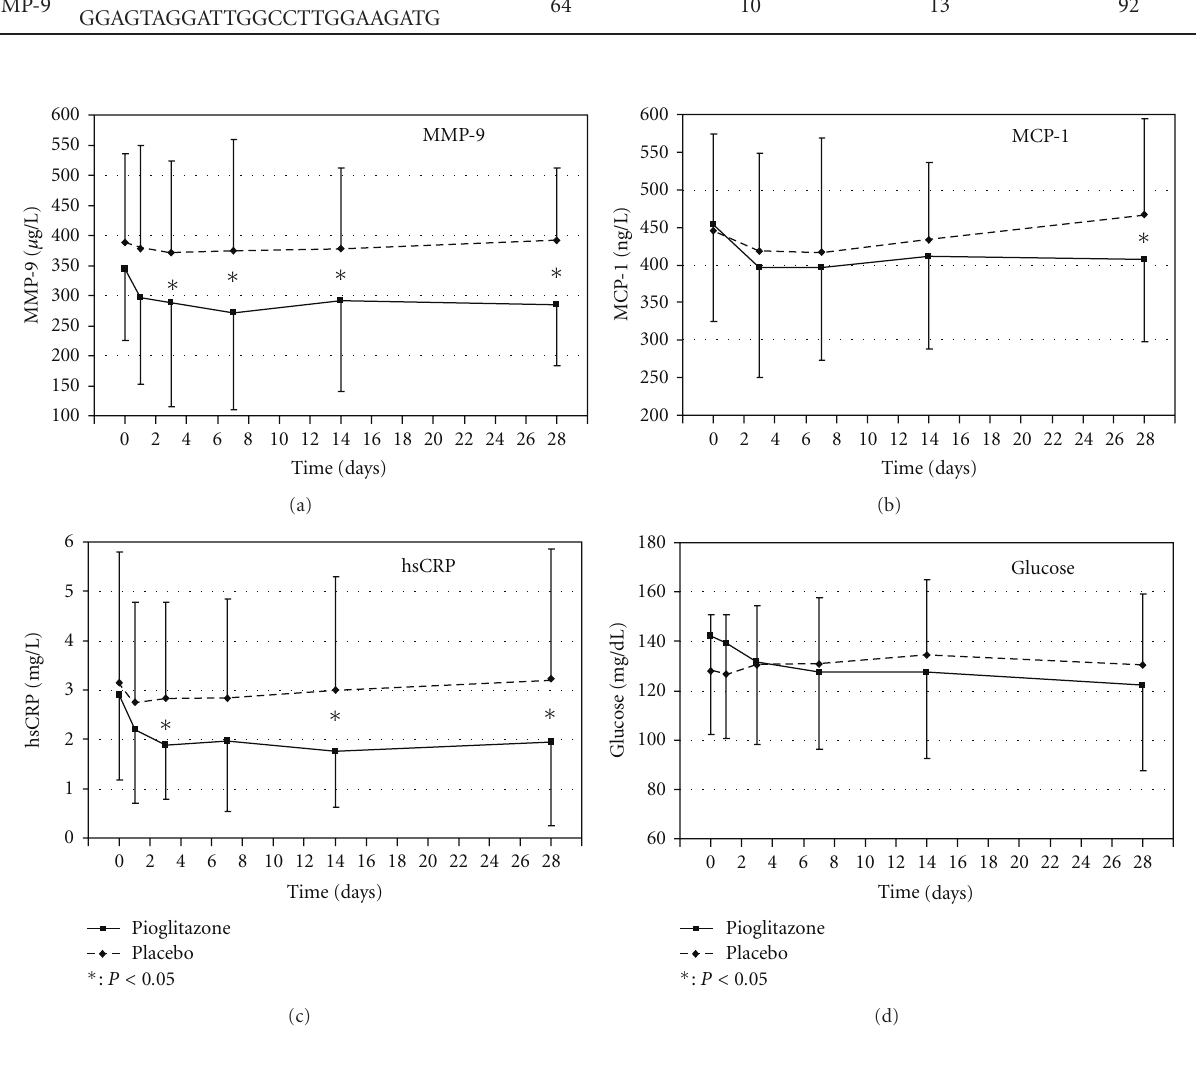
Figure 1: Changes in plasma concentrations of MMP-9, MCP-1, hsCRP, and glucose during the four-week observation